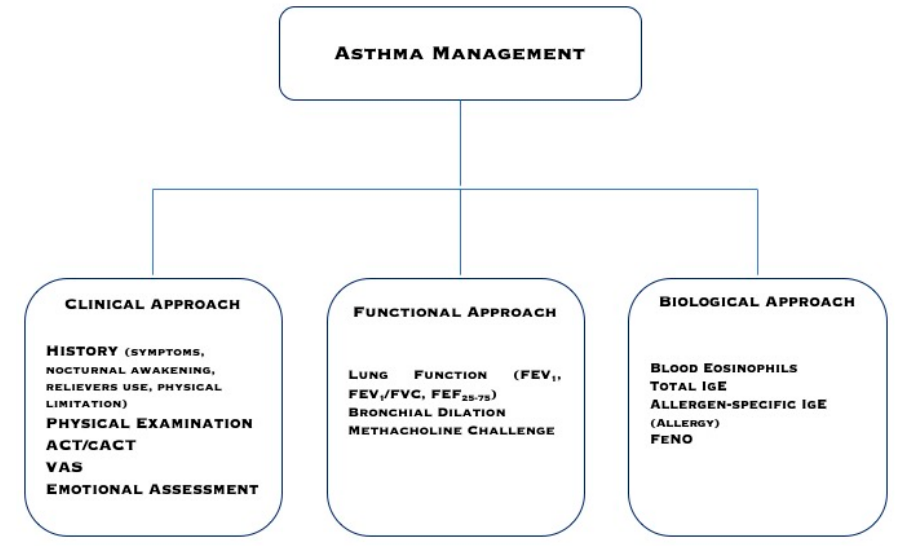
Figure 1. A pragmatic approach to manage asthmatic patients.